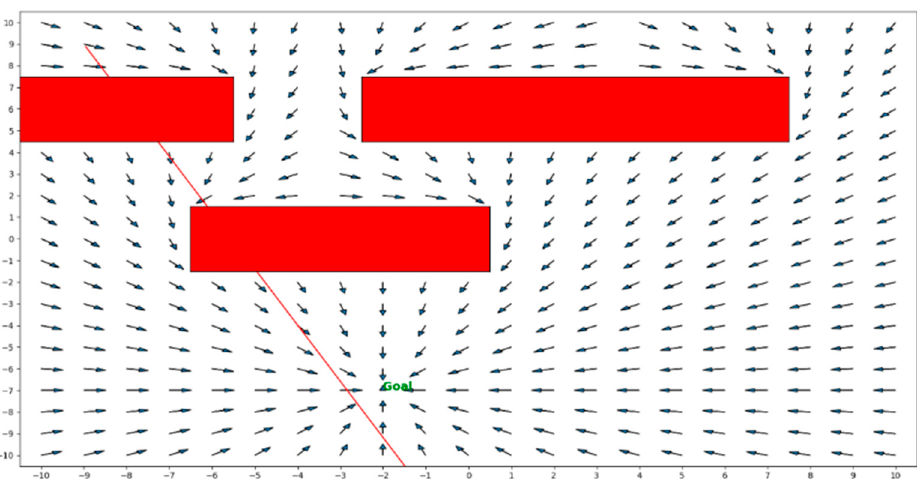
Figure 16. Collision with obstacles ( green ), collision avoidance by sampling more experiences close to obstacles ( blue ).